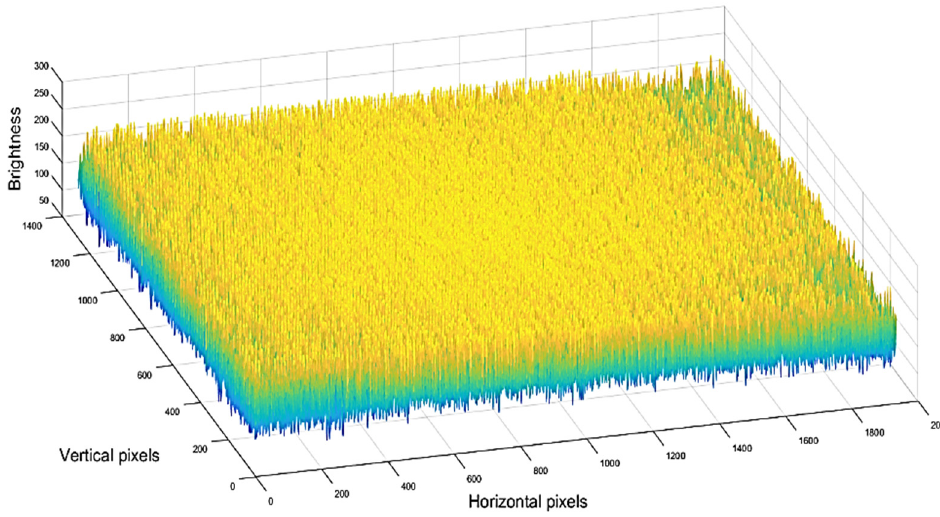
Figure 3. Brightness surface of the R channel for fabric with label 20/6/21.